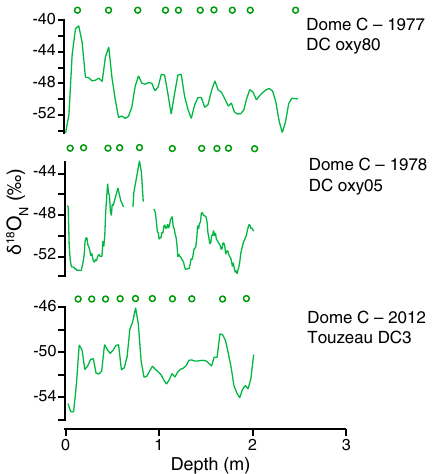
Figure 8. Isotopic composition profiles from three snow pits at Dome C; see Table 3. Successive maxima are marked with cir- cles and indicate the pseudo-cycles for each profile. A threshold of 1.5‰ in δ 18 O N was applied to distinguish successive local minima and